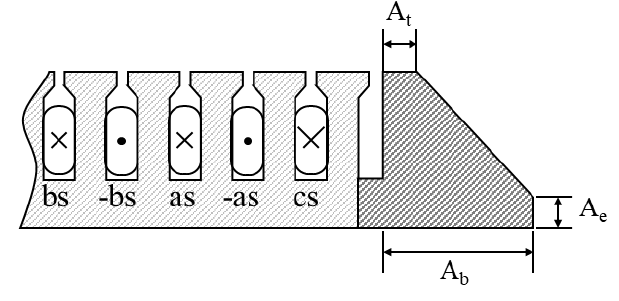
Figure 15. End edge auxiliary teeth.